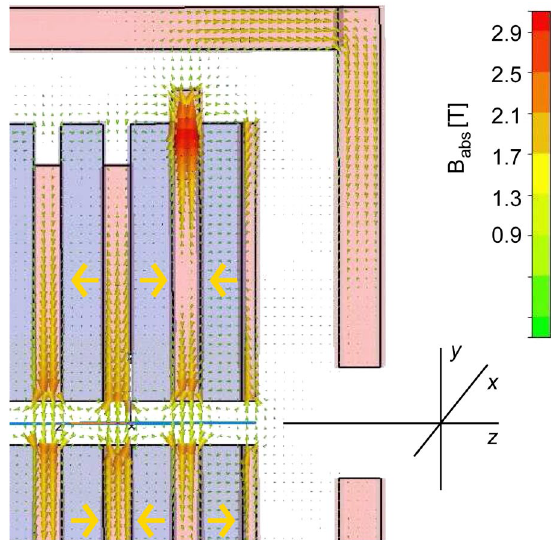
FIG. 4. (Color) False color arrows indicate the direction and strength of the magnetic B -field in the y - z plane of the hybrid undulator. The field at the pole tips amounts to (cid:7) 2 T , the field on axis to (cid:7) 0 : 9 T . In the simulation, corresponding B y; 0 the magnetization of the thin permanent magnets, indicated by yellow arrows, was set to 1.3 T. Slight tuning of the field on axis can be achieved by coupling the upper part of the ferromagnetic plates to the outer yoke structure, as displayed for the tuning of the end